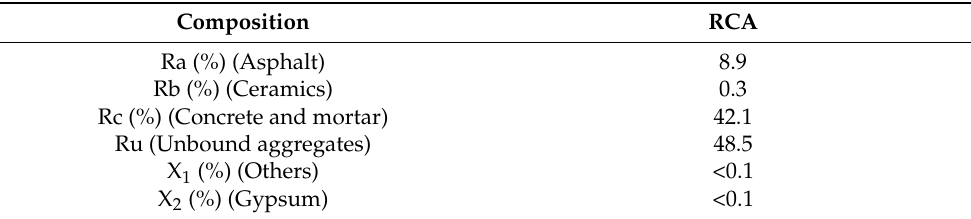
Table 1. Constituents of recycled concrete aggregates (RCA) determined according to EN 933-11:2009 [34].